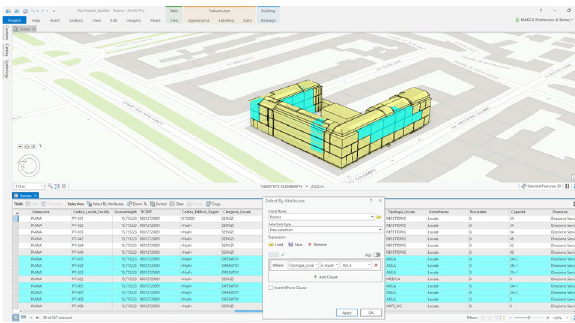
Figure 10. Room entity-based queries performed on different buildings according to EDISCO database on schools buildings BIM model into